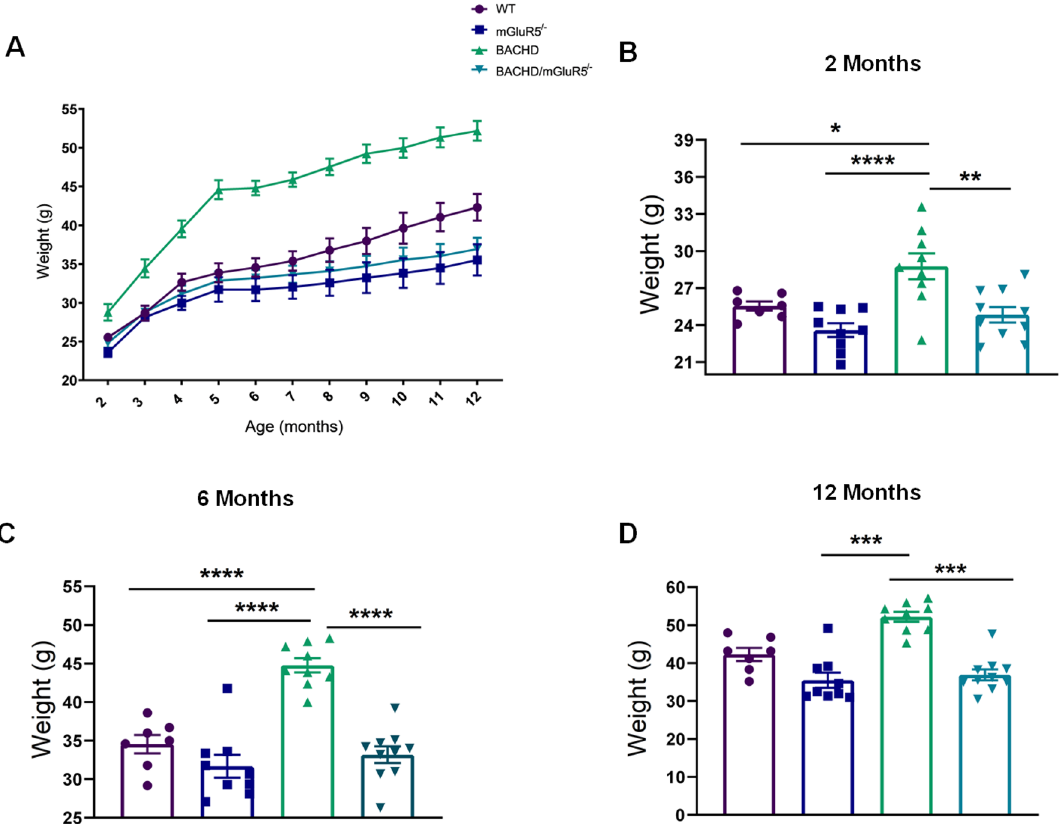
Figure 2. mGluR5 genetic deletion decreases body weight in BACHD mice. ( A ) Body weight measurements of WT, mGluR5 −/− , BACHD and BACHD/mGluR5 −/− mice from 2 to 12 months showed an interaction effect between time and genotype (F( 30,329 ) = 4,302). ( B – D ) Body weight of all tested groups at 2, 6 and 12 months of age. Error bars represent the mean ± SEM; n = 7–11. Repeated measures ANOVA and mixed model followed